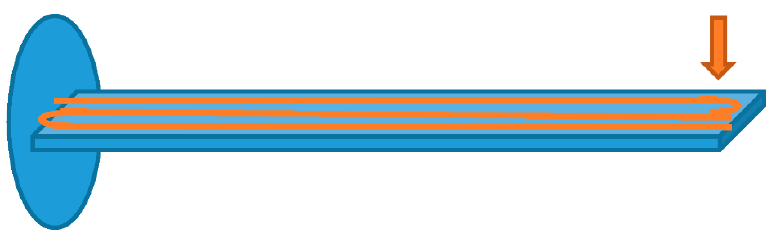
Figure 6. Cantilever beam used for modal analysis experiments [52].